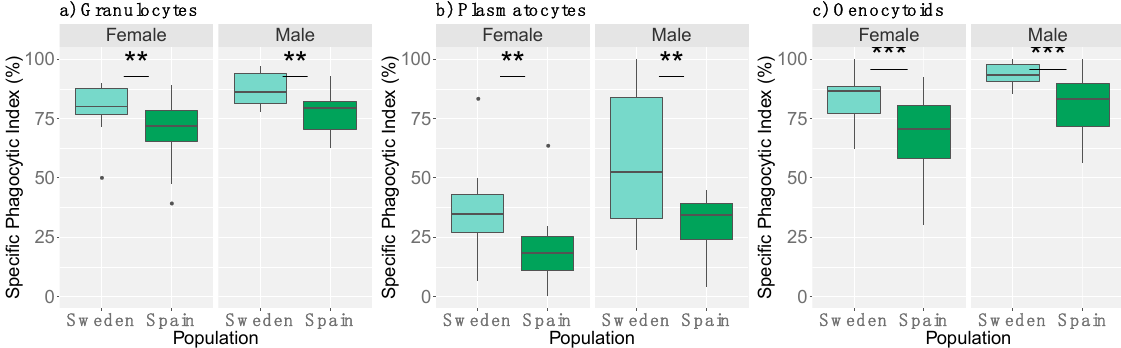
Figure 6. The specific phagocytic index of (a) granulocytes, (b) plasmatocytes, and (c) oenocytoids as measured via imaging ( N = 44). Populations differed in their cells’ propensity to phagocytose. In addition, the sexes also differed ( p < 0.05 *). Bar plots are as described previously. Asterisks denote significance (*: P ≤ 0.05; **: P ≤ 0.01; ***: P ≤ 0.001). Note the differences in y-axis.